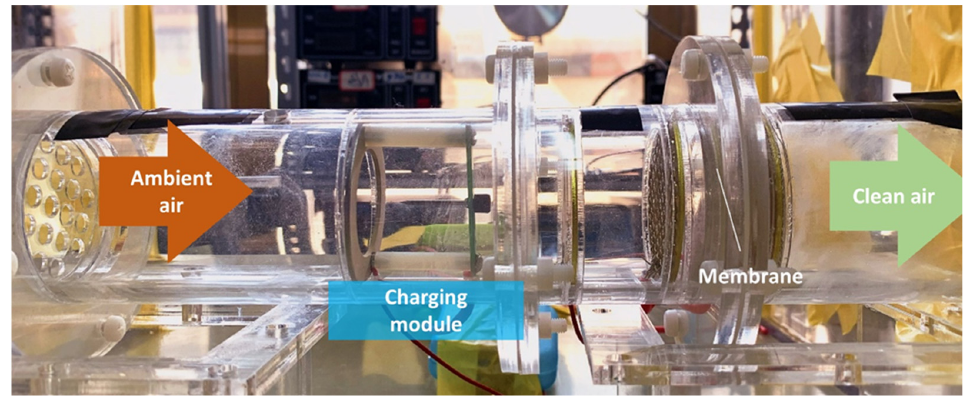
Figure 3. Real image of the setup used to investigate the filtration performance of the filter materials.